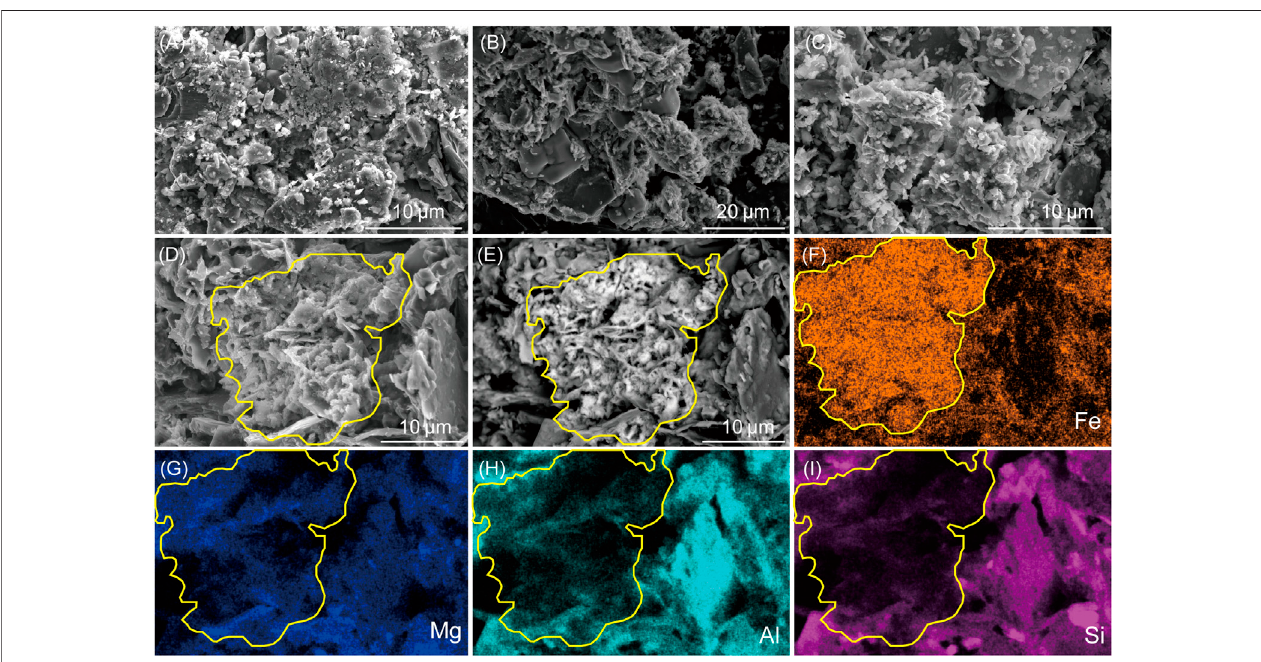
FIGURE 5 | SEM micrographs of the clay minerals. (A) Clay morphology from sample 0718. (B) Clay morphology from sample 0719. (C) Clay morphology from sample1222-3A. (D) Amorphousmaterialsonthesurfaceofclaygrains. (E) Backscatteredelectronimageoftheamorphousmaterials. (F) DistributionofFeinthesame area as (E) . (G) Distribution of Mg in the same area as (E) . (H) Distribution of Al in the same area as (E) . (I) Distribution of Si in the same area as (E) .